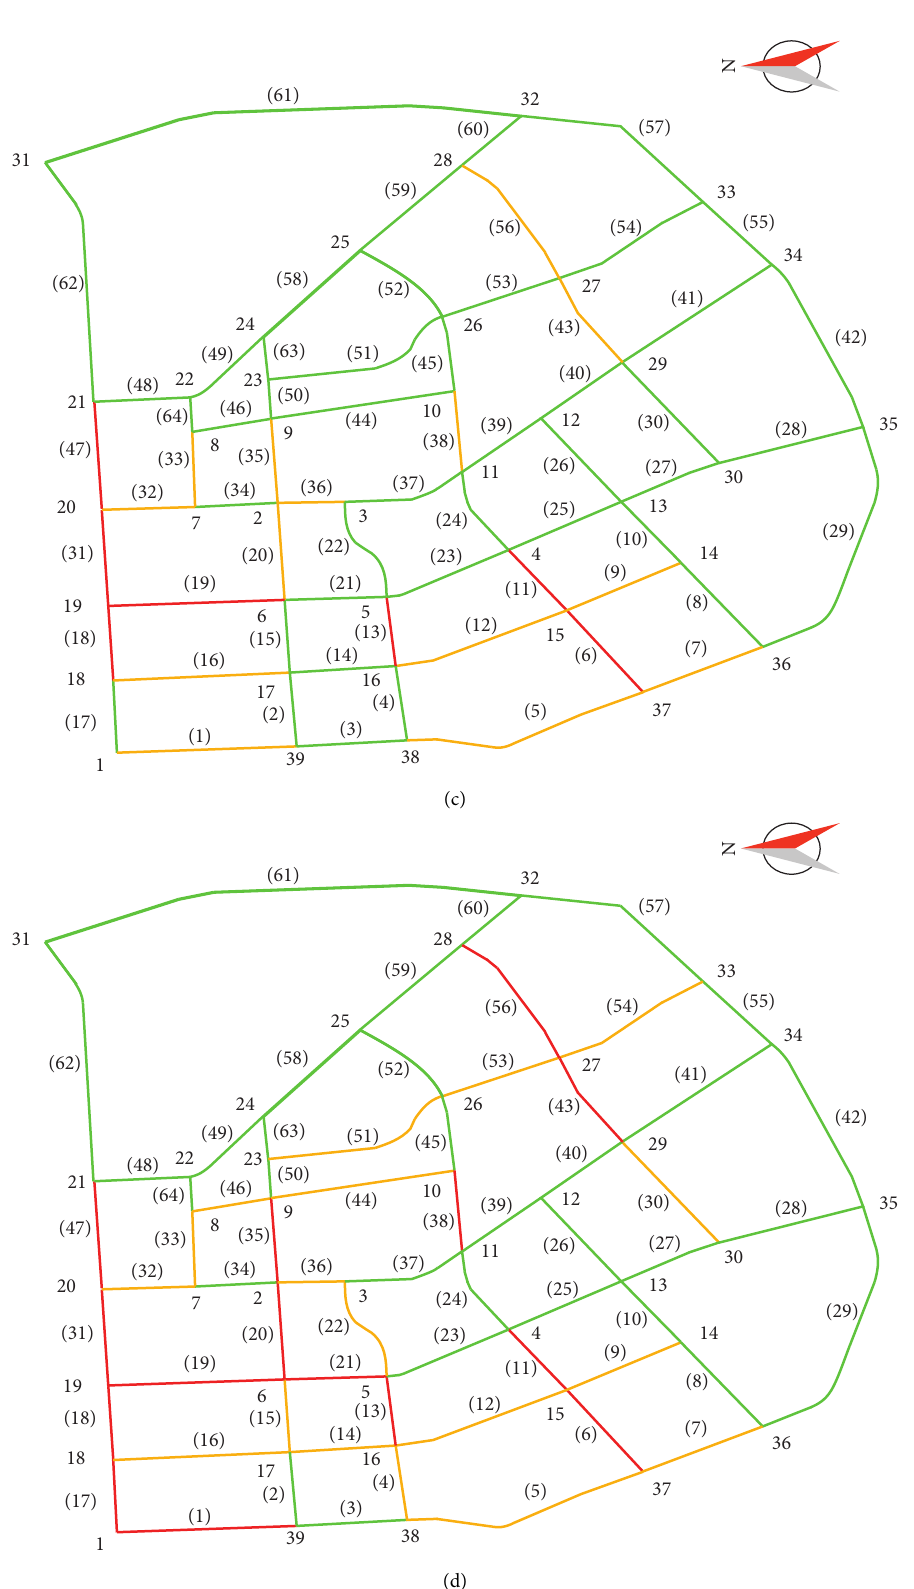
Figure 6: Road network reliability diagram under different seismic intensities: (a) VI; (b) VII; (c) VIII; (d) IX. Green lines represent the road links being in the reliable state, yellow represents medium reliable, and red represents